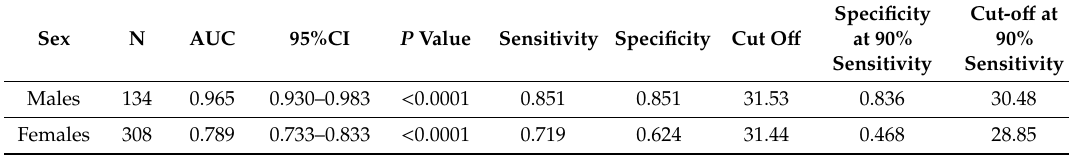
Table 2. Diagnostic performance of the BMI cut off points to detect obesity by sex groups.